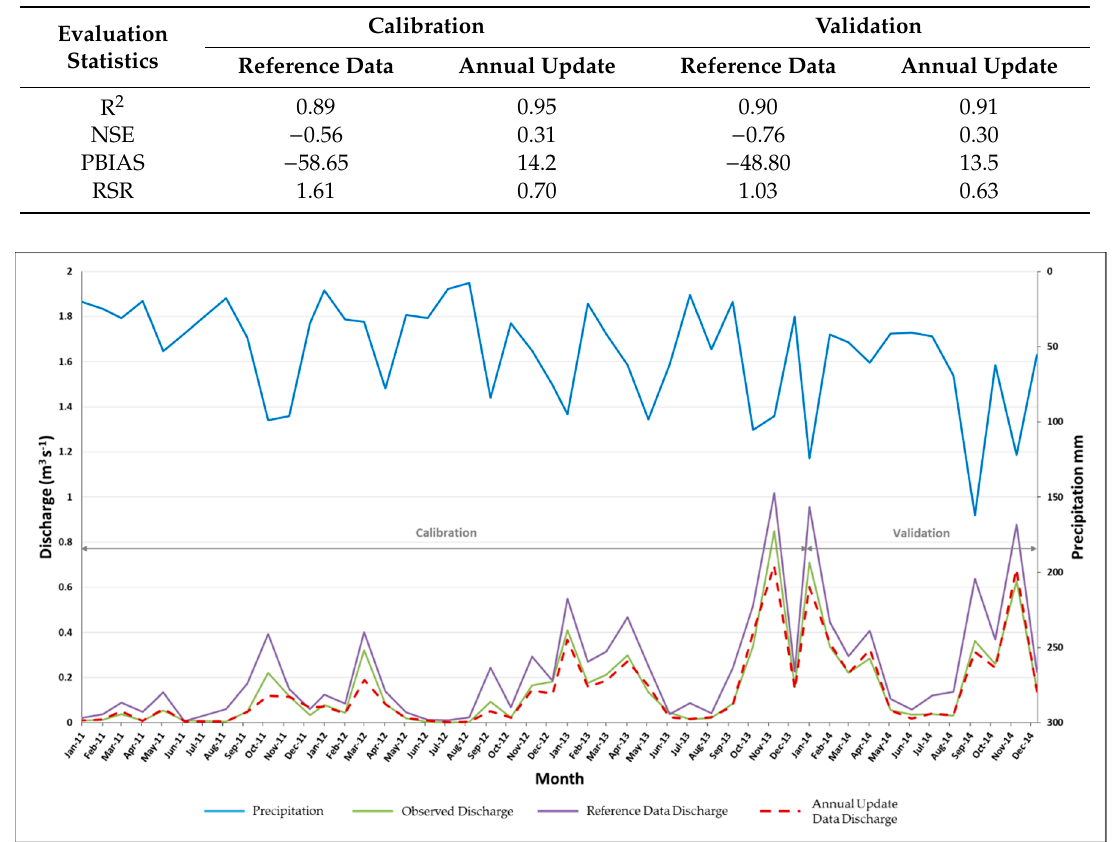
Table 3. Statistical metrics of calibration and validation phases.